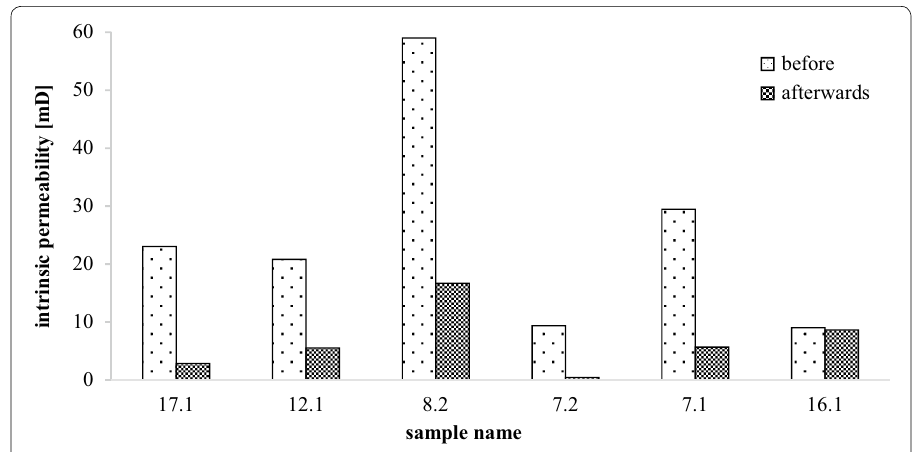
Fig. 2 Intrinsic permeability of the rock samples before and after the experimental runs. On the y axis the intrinsic permeability (mD) is shown. The x axis displays the used samples (identified by their number/name). White bars with few dots illustrate the permeability of the unpercolated rock samples whereas the strongly dotted bars show the permeability of the percolated rock samples after the experiment